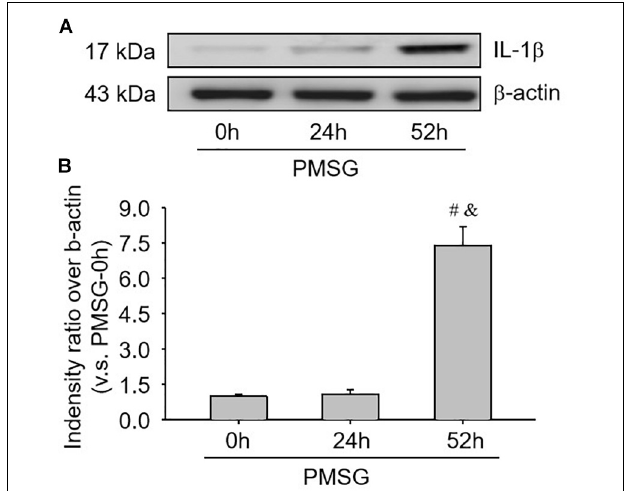
FIGURE 6 | IL-1 β protein expressions in the ovary during the follicular development induced by PMSG. (A) Representative ECL gel images of Western blot analyses depicting the IL-1 β protein levels. (B) Summarized intensities of IL-1 β blots normalized to the control. Each value represents the mean ± SE. One-way analysis of variance (ANOVA) was used to analyze the data, followed by a Tukey’s multiple range test. n = 6. # P < 0.05, vs. PMSH-0 h; & P < 0.05, vs. PMSH-24 h.